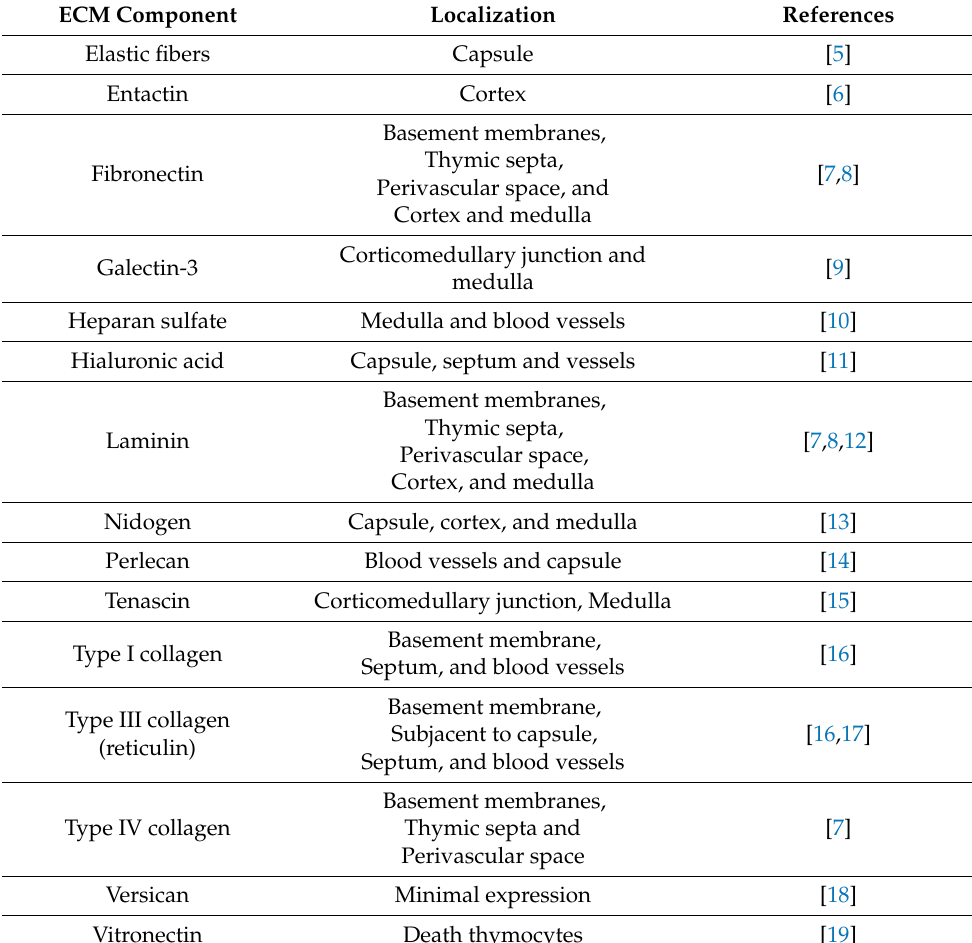
Table 1. Major extracellular matrix components of